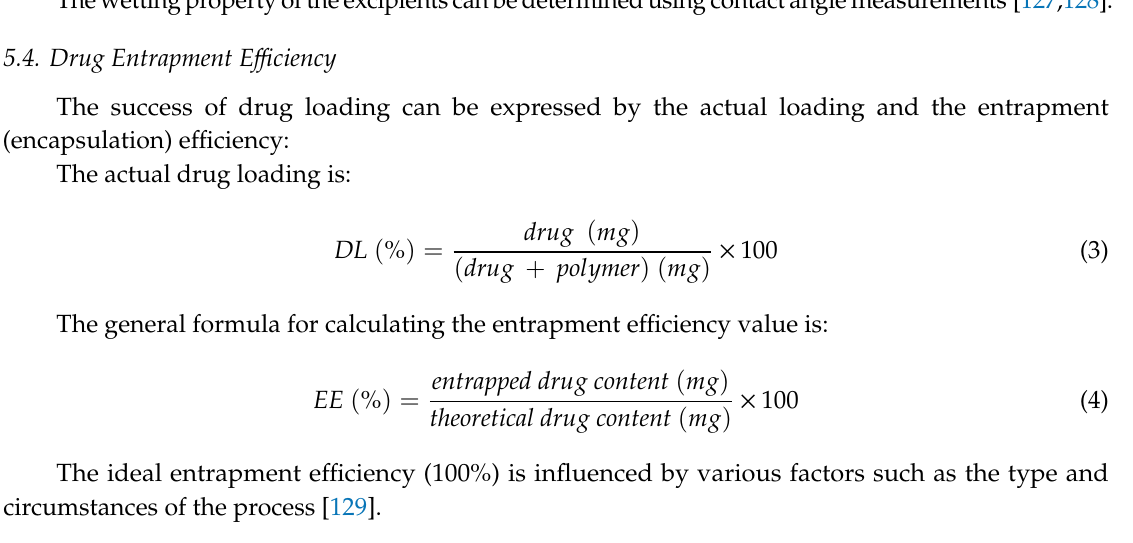
Figure 10. Swelling of air-dried O/W alginate (2%) microparticles (prepared using a Büchi B-390 Microencapsulator) in a pH 6.8 phosphate buffer: ( a ) initial, ( b ) after 5 min, ( c ) after 15 min, and ( d ) after 30 min (the oil phase contained Sudan III. as an indicator). Images: Nikon SMZ 1000 Stereomicroscope.